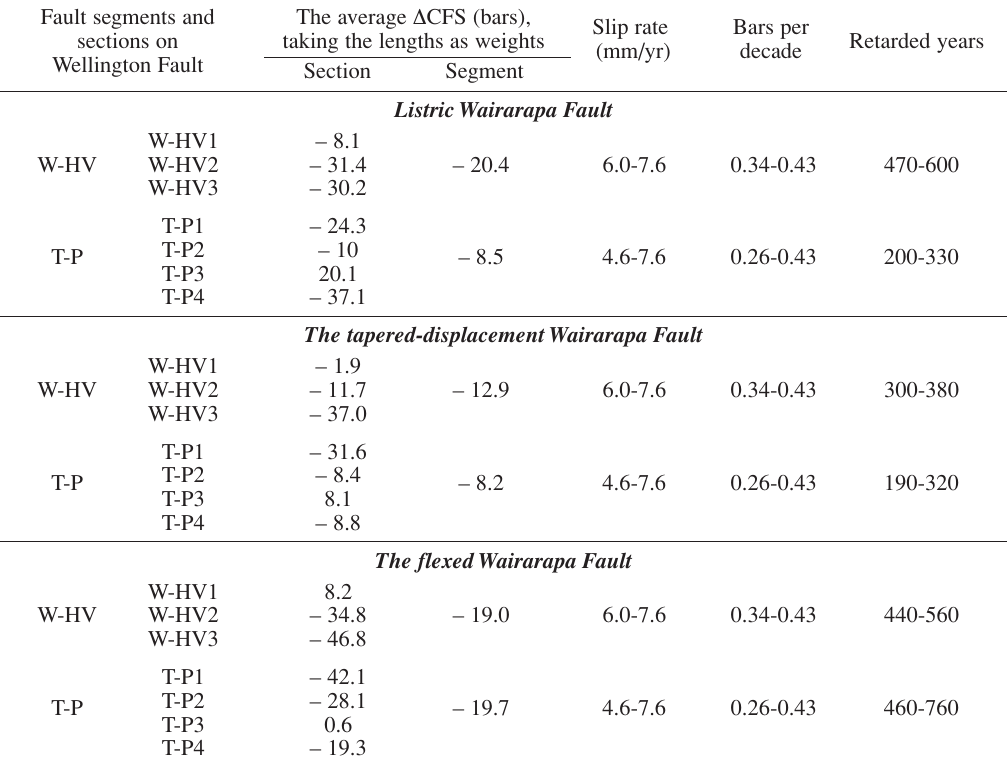
Table IV. The average (cid:54) CFSs and their influence on the seismic risk. Fault segments and The average (cid:54) CFS (bars), Slip rate Bars per sections on taking the lengths as weights (mm/yr) decade Retarded years Wellington Fault Section Segment Listric Wairarapa